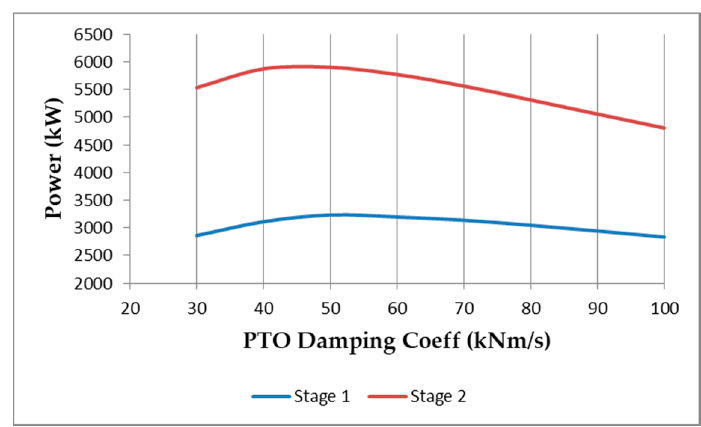
Figure 6. PTO damping vs. power capture.